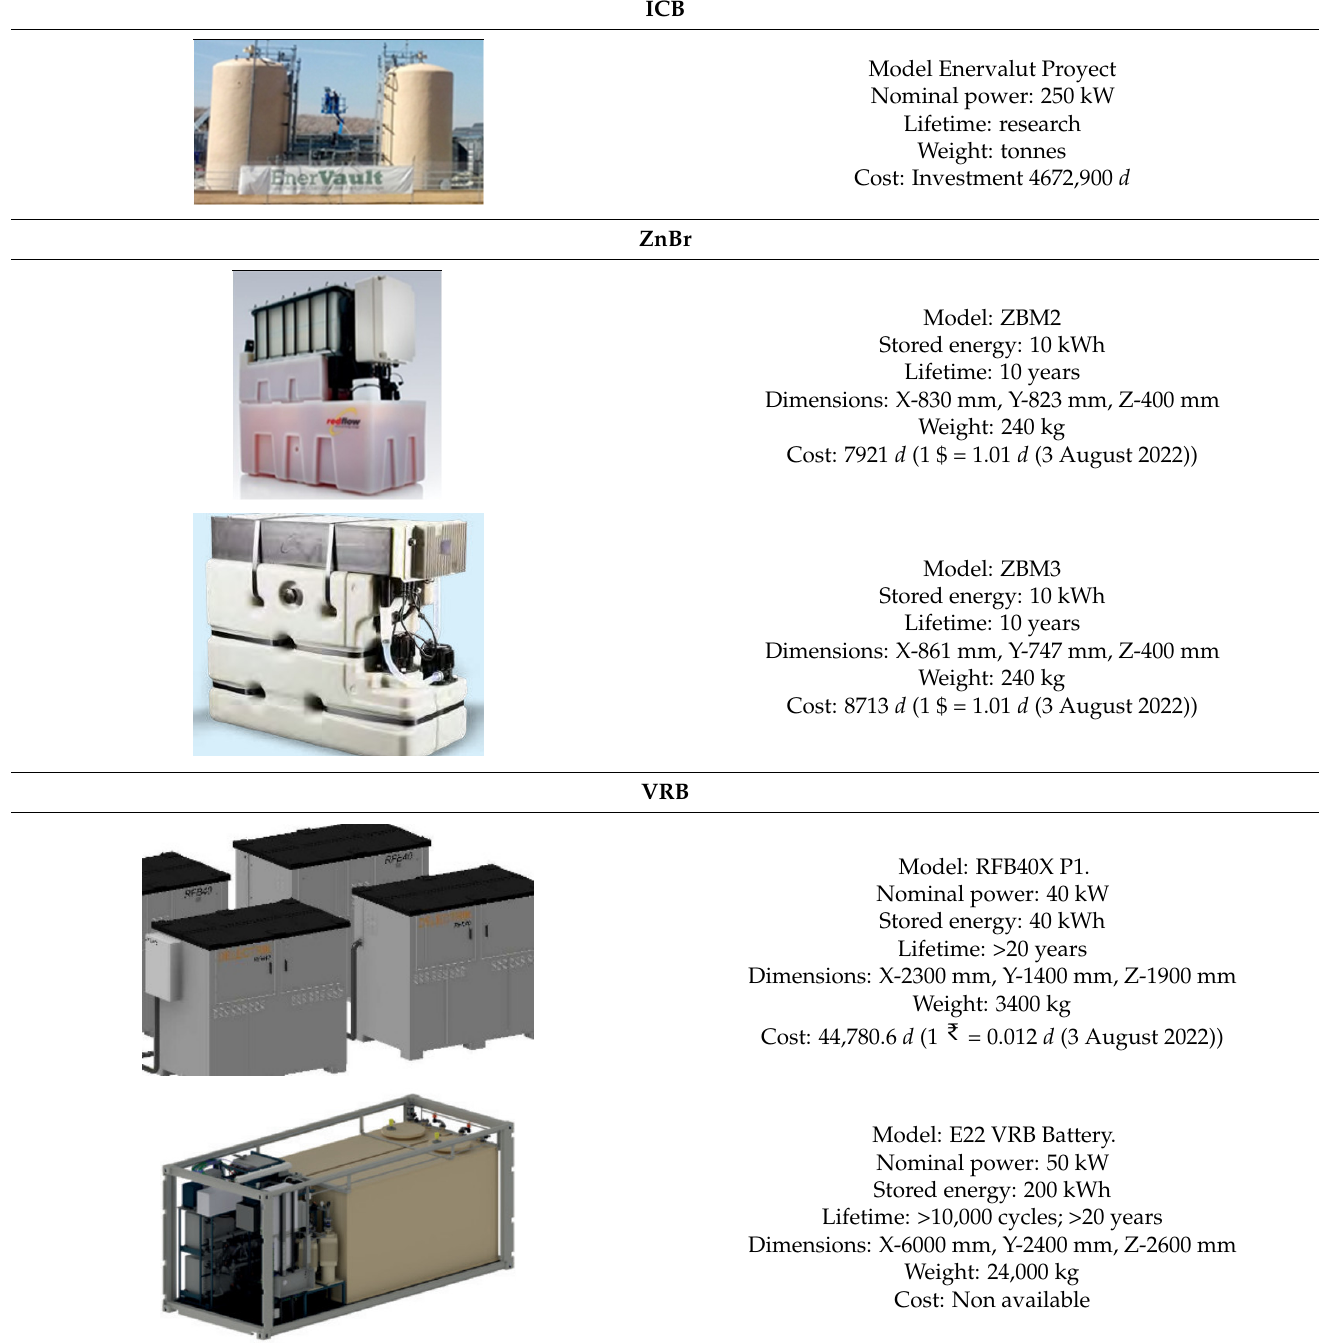
Table A3. Commercial examples of Redox Flow Batteries. Data provided by the manufacturer.